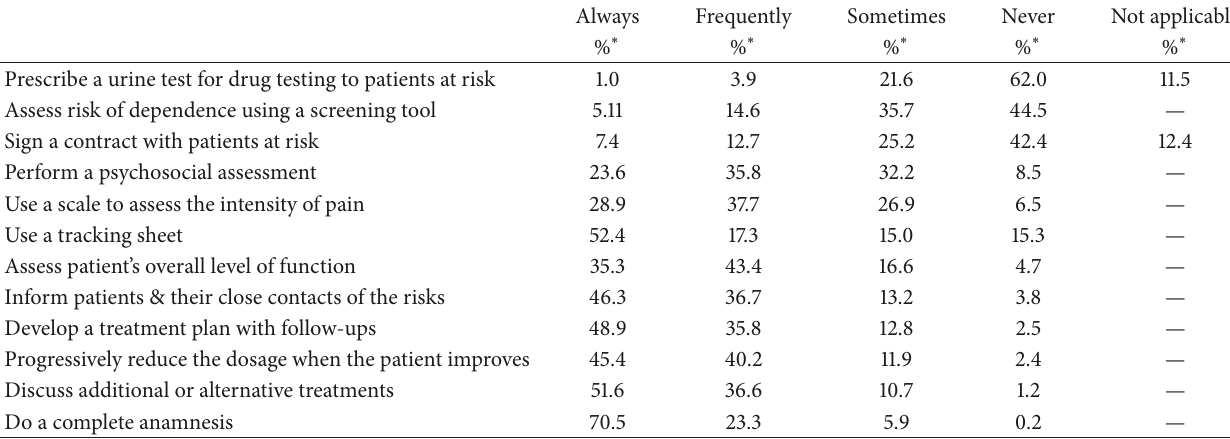
Table 5: Rates of compliance to the CMQ guidelines ( 𝑛 = 636 ).